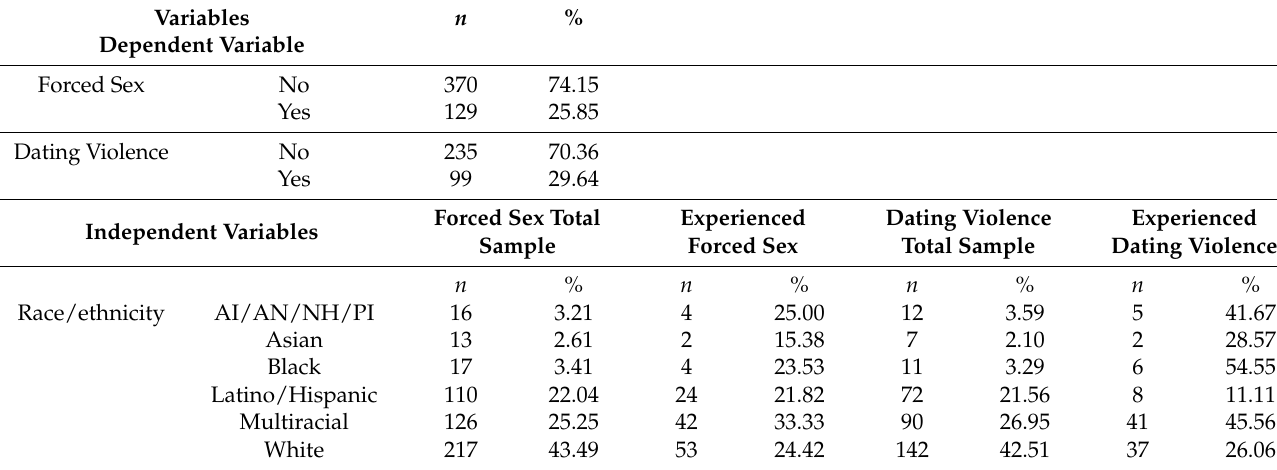
Table 1. Descriptive statistics for all study